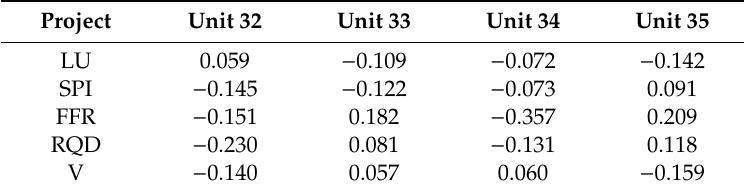
Table 8. The prospect decision